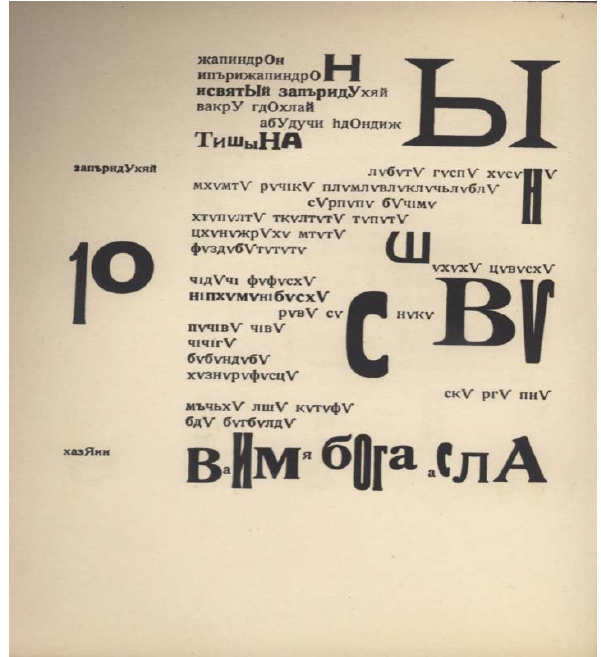
Figure 1. Ledantu le phare: Poème dramatique en